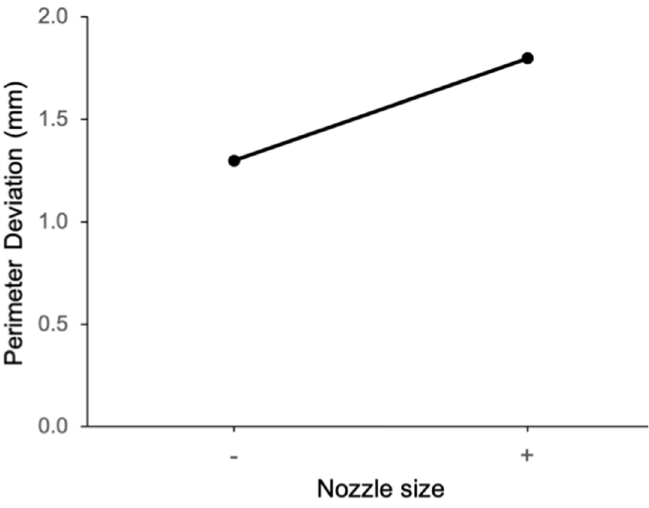
Figure 7. Main effect of nozzle size on perimeter deviation.